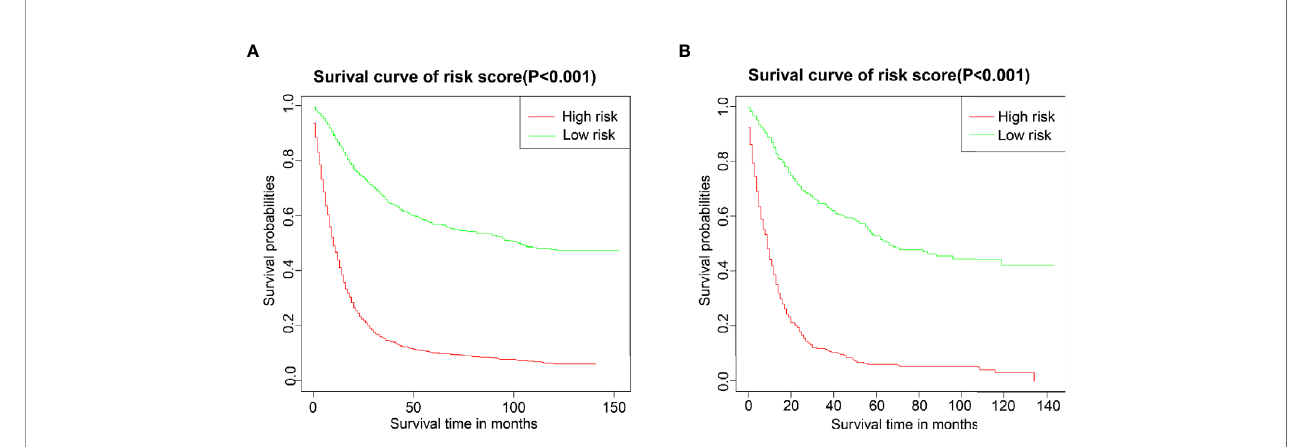
FIGURE 6 | Overall survival (OS) Kaplan-Meier curves for patients in the low- and high-risk groups. (A) training group; (B) validation